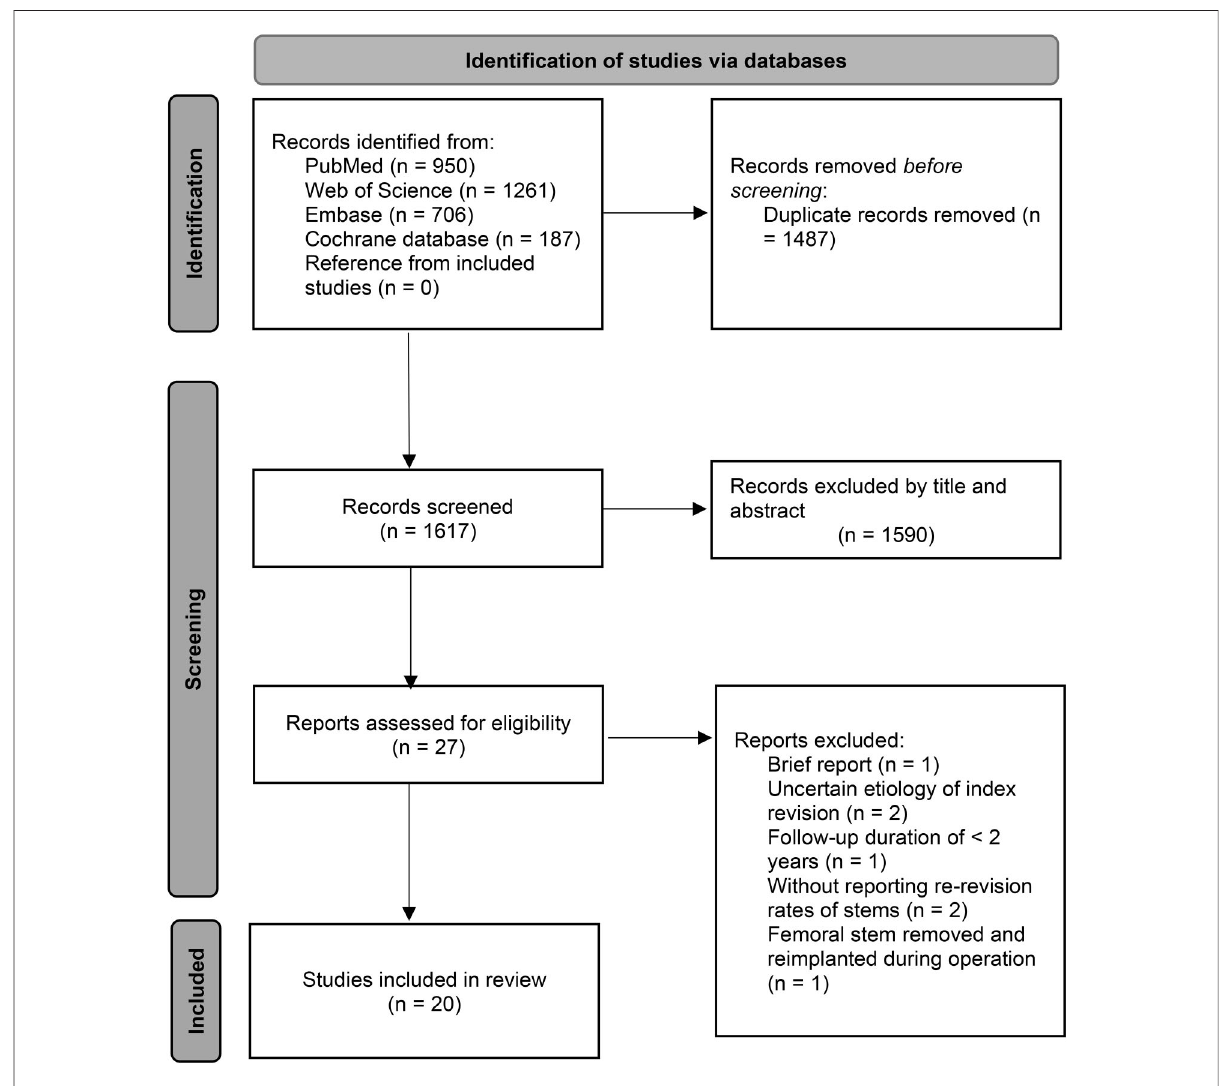
FIGURE 1 Flowchart of